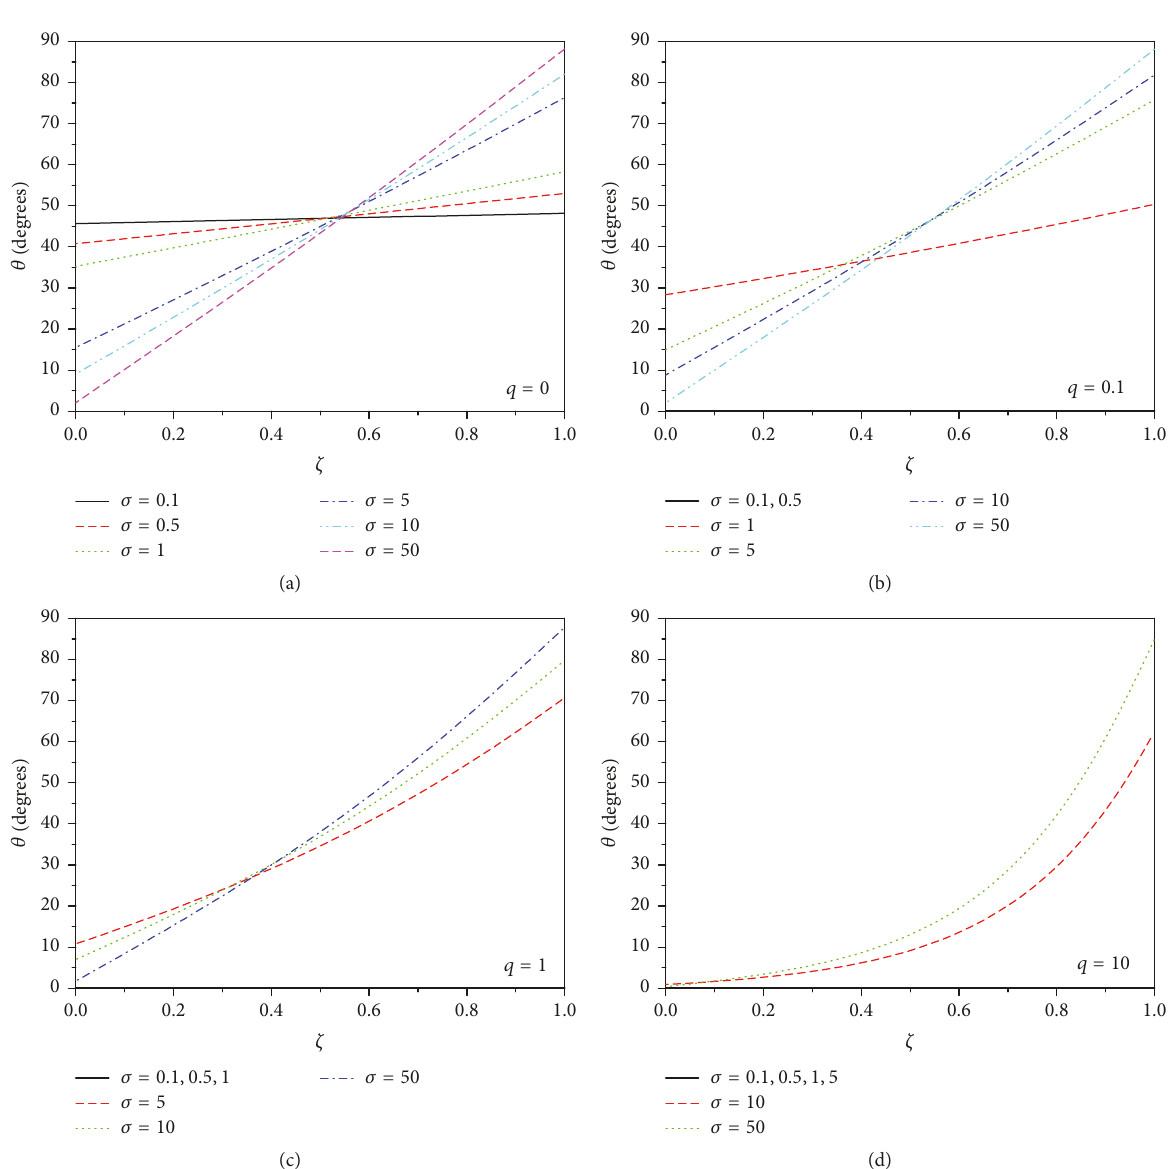
Figure 2: Nematic’s director as a function of 𝜁 fore 5CB at 𝑇 = 25.1 ∘ C for (a) 𝑞 = 0 , (b) 𝑞 = 0.1 , (c) 𝑞 = 1 , and (d) 𝑞 = 10